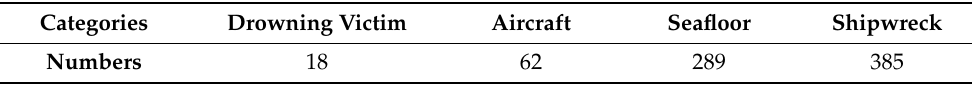
Table 1. The number of images per category in the dataset.